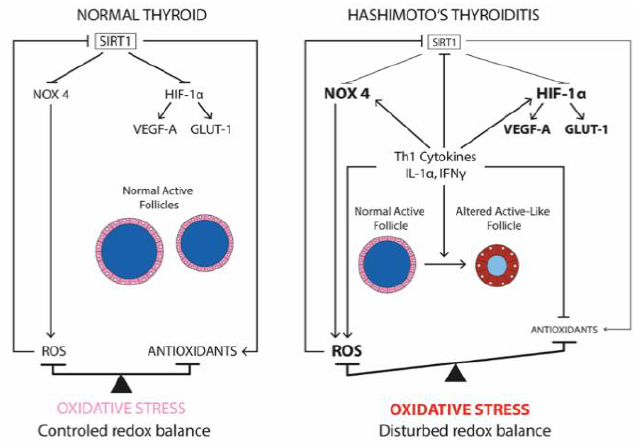
Figure 7. SIRT1 is a new, possible key element in the physiopathogenesis of Th1 autoimmune Hashimoto’s thyroiditis. In normal thyroid, the redox balance is properly controlled and SIRT1 is expressed in the thyrocytes’ cytoplasm, mainly in active follicles. In Hashimoto’s thyroiditis, Th1 cytokines increase ROS production by upregulating NOX4 and decreasing the antioxidant enzymes such as PRDX1, catalase, and SOD1. The disruption of the redox balance induces an oxidative stress, particularly in altered active-like follicles. HIF-1 α and its targets, VEGF-A and GLUT-1, are overexpressed by Th1 cytokines and in Hashimoto’s patients. The downregulation of SIRT1 by Th1 cytokines and in Hashimoto’s patients is a key event in the thyroiditis pathogenesis since SIRT1 has been shown in other cell types to be able to modulate oxidative stress by regulating NOX4 and HIF-1 α . (T) inhibitor arrow and ( ↑ ) activator